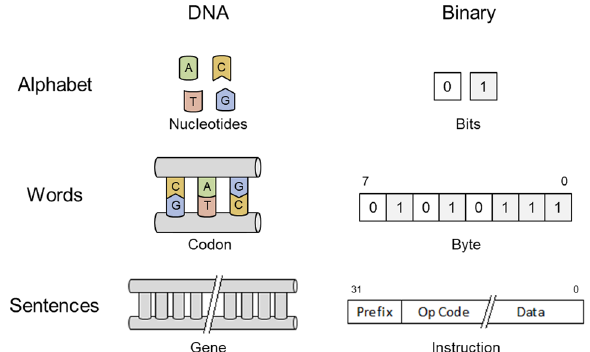
Figure 2. Comparison of biological and digital languages.